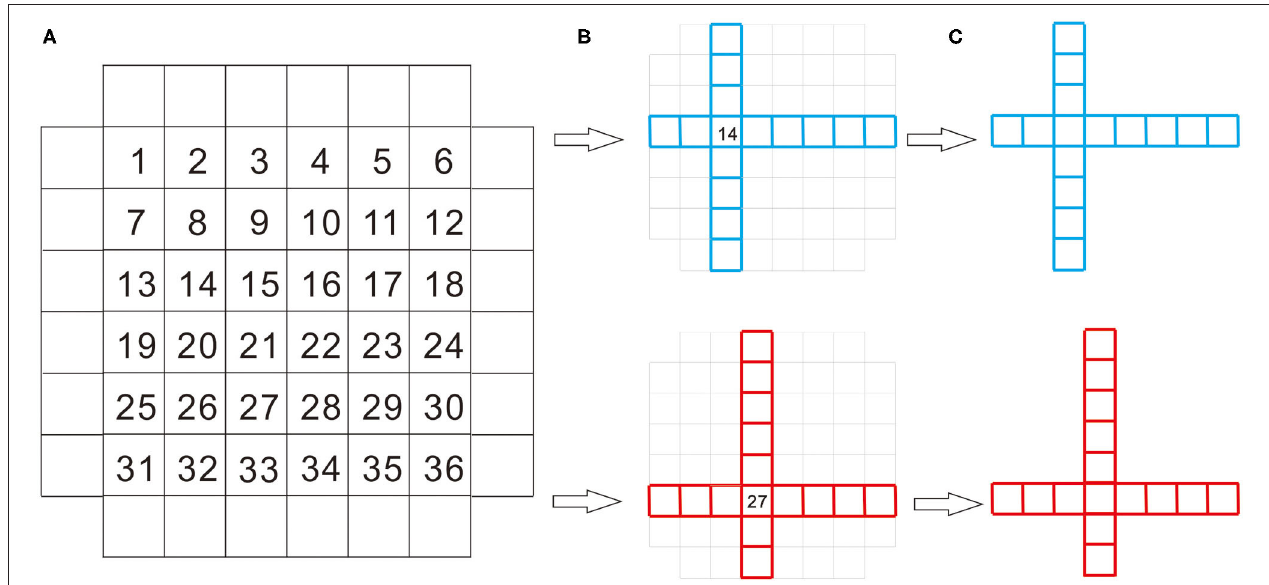
FIGURE 1 | The process of stimulus formation. The stimuli used in the present study comprised a set of 36 abstract geometric shapes (AGSs). AGSs are composed of a series of squares arranged horizontally, plus a vertical series. There was always the same number of squares horizontally and vertically. The 36 numbers in (A) represent the space where the two series cross and 36 stimuli. AGSs differ by the number of squares below and above, as well as the left and right of the overlapping square (B) . Two of AGSs are shown as examples in (C)